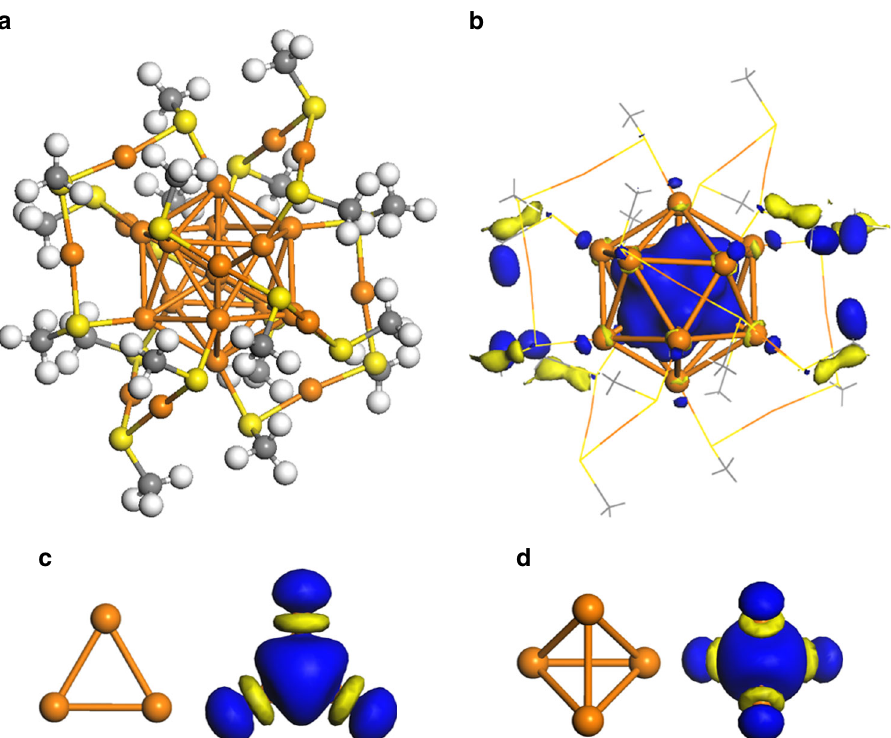
with R being CH 3 . b The 1 S orbital of Au 25 (RS) (cid:2) . The protecting 18 18 . d The structure and 1 S orbital of Au 2 þ . Atomic color code: 4 3